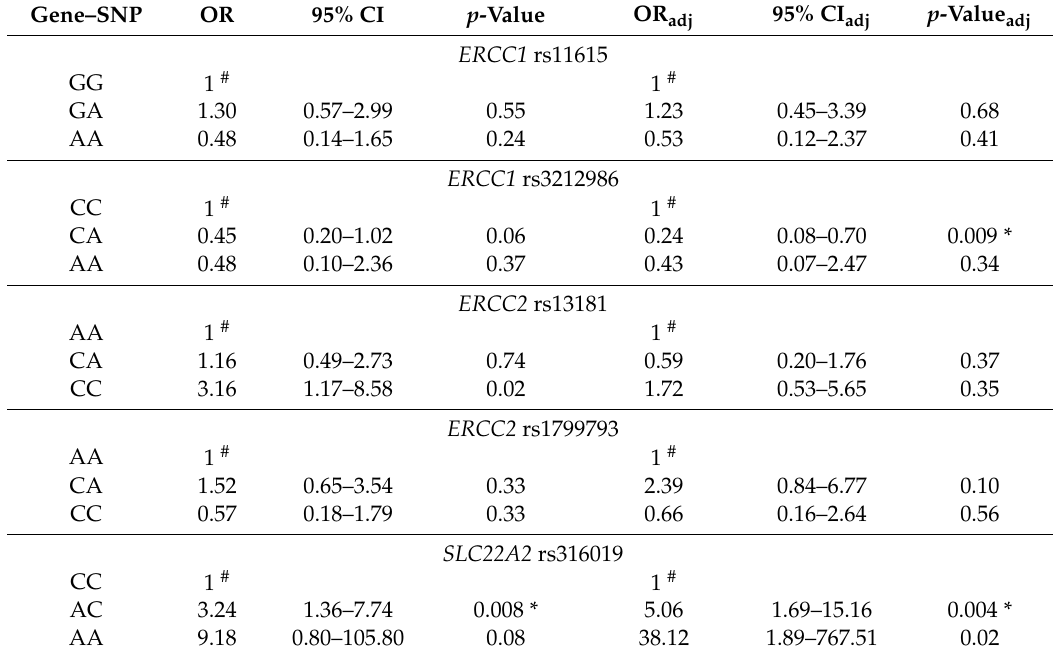
Table 7. Strength of genotypic association between genetic polymorphisms and cisplatin nephrotoxicity in CTCAE-AKI designation (N =